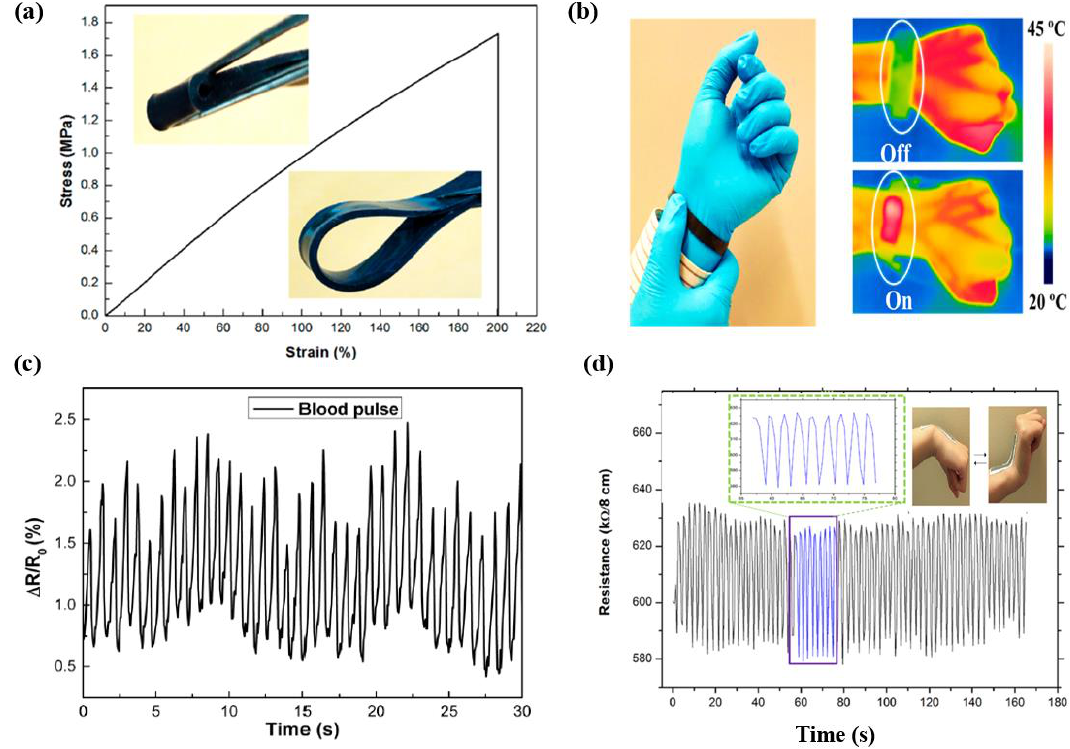
Figure 9. ( a ) Typical tensile strain-stress curve of CS/PDMS composite, ( b ) Infrared images of multifunctional wrist band worn by a volunteer as a wearable heater at on and off modes, ( c ) relative change of resistance (RCR) response of the wrist band to blood pulse of an adult volunteer; monitoring of the breathing, reproduced with permission from [110], published by ACS Publications, 2016; and ( d ) the upward/downward motion of wrist recorded by rGO-based cotton fabric sensors, and inset shows the magnified version of blue box in image ( d ) in the time range of 57 – 77 s, reproduced with permission from [111], published by ACS Publications, 2017.